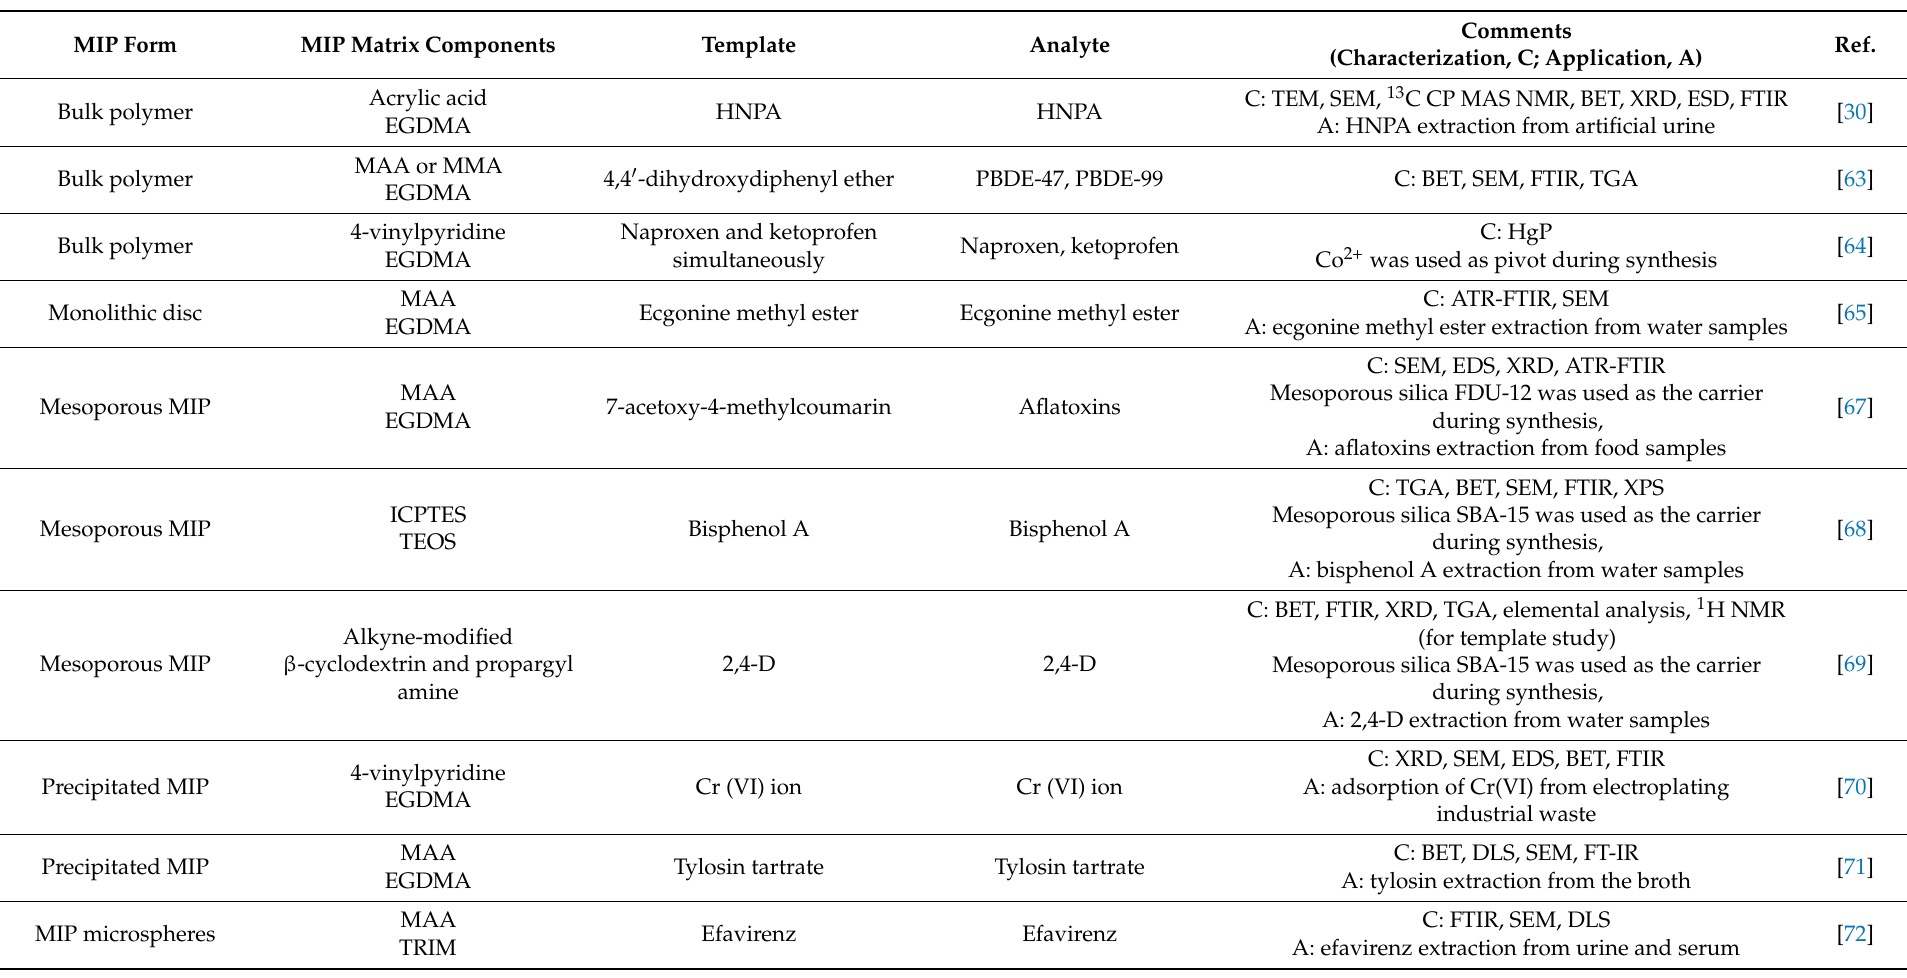
Table 1. Summary of various forms of molecularly imprinted polymers (MIPs) together with their composition details, characterization methods, and application in the separation process. MIP